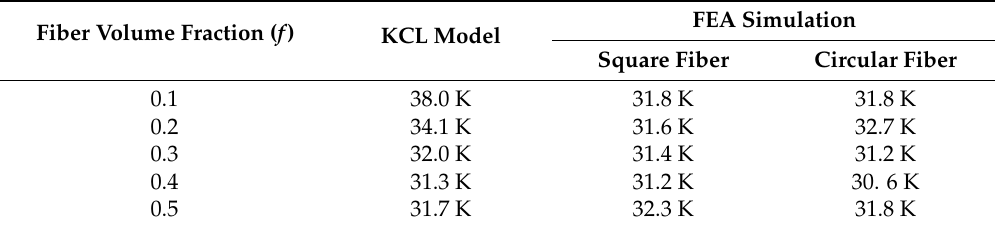
Table 2. Comparison of ∆ T max between the KCL model and FEA simulations.